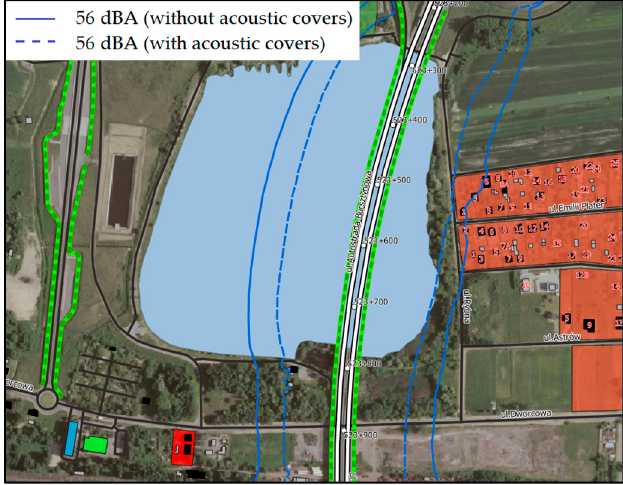
Figure 15. The results of the acoustic modeling—with and without the use of the acoustic covers on the expansion joints for a night.